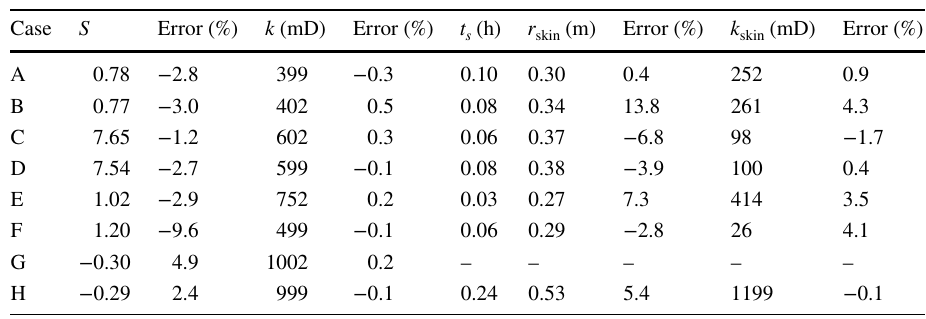
Fig. 4 Pressure and derivative data for case